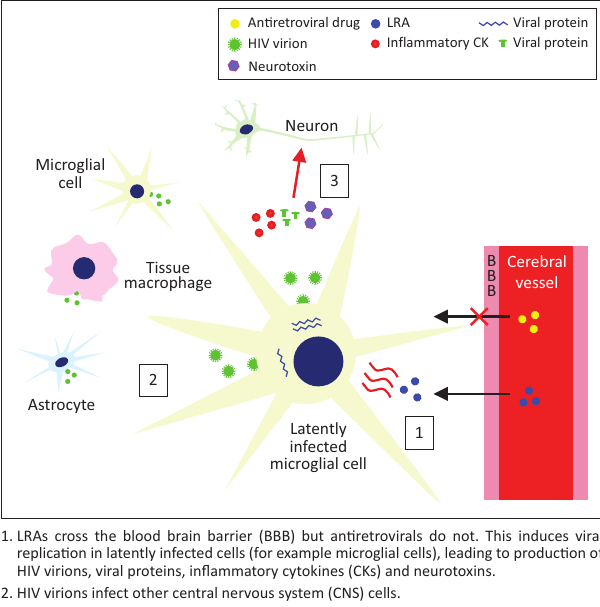
FIGURE 2: Proposed mechanism for human immunodeficiency virus associated neurological disorder development on latency reversing agent